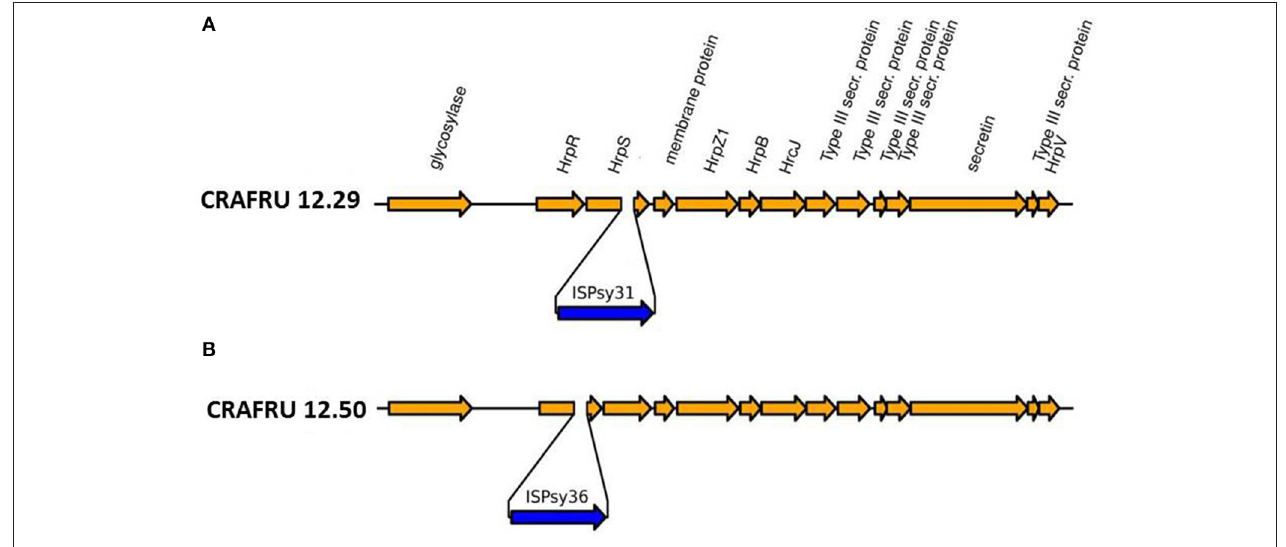
FIGURE 3 | Drawing of part of the hrp cluster of Psa, with the location of the insertion of (A) ISPsy31 in strain CRAFRU 12.29 and (B) ISPsy36 in strain CRAFRU 12.50.